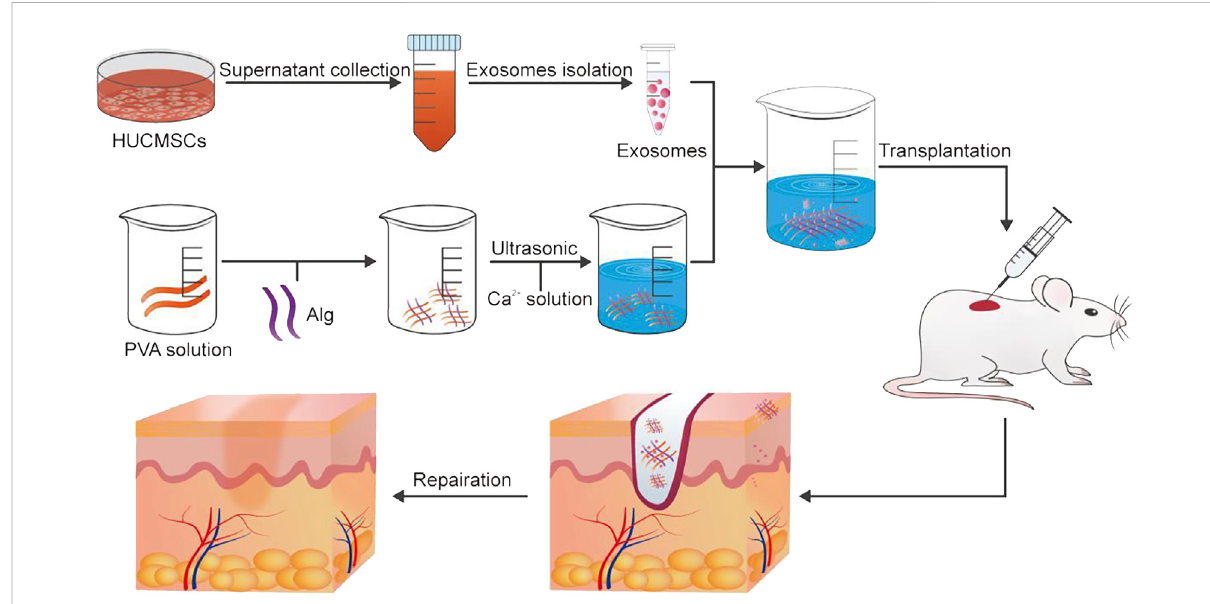
FIGURE 6 The preparation method of exosomes and the application of exosomes in wound healing. Reproduced from (Zhang Y. et al., 2021), with permission from